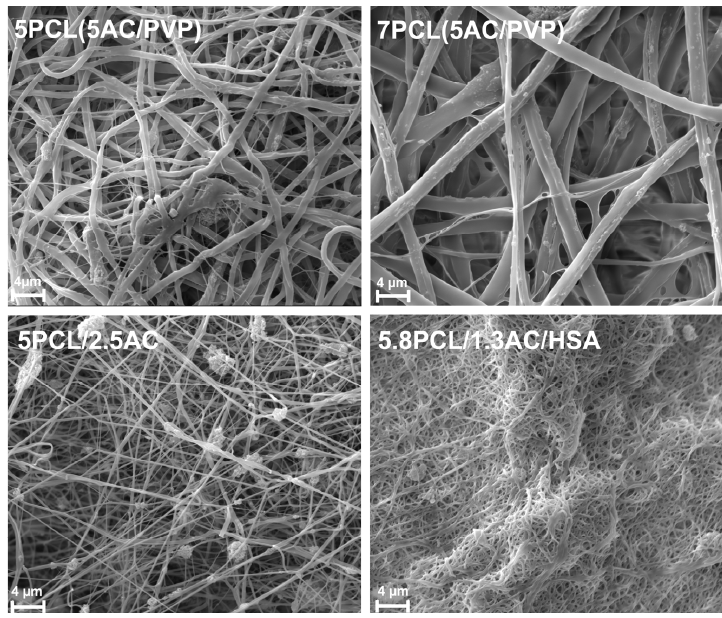
Figure 2. SEM images of ACN-enriched ES-produced scaffolds.